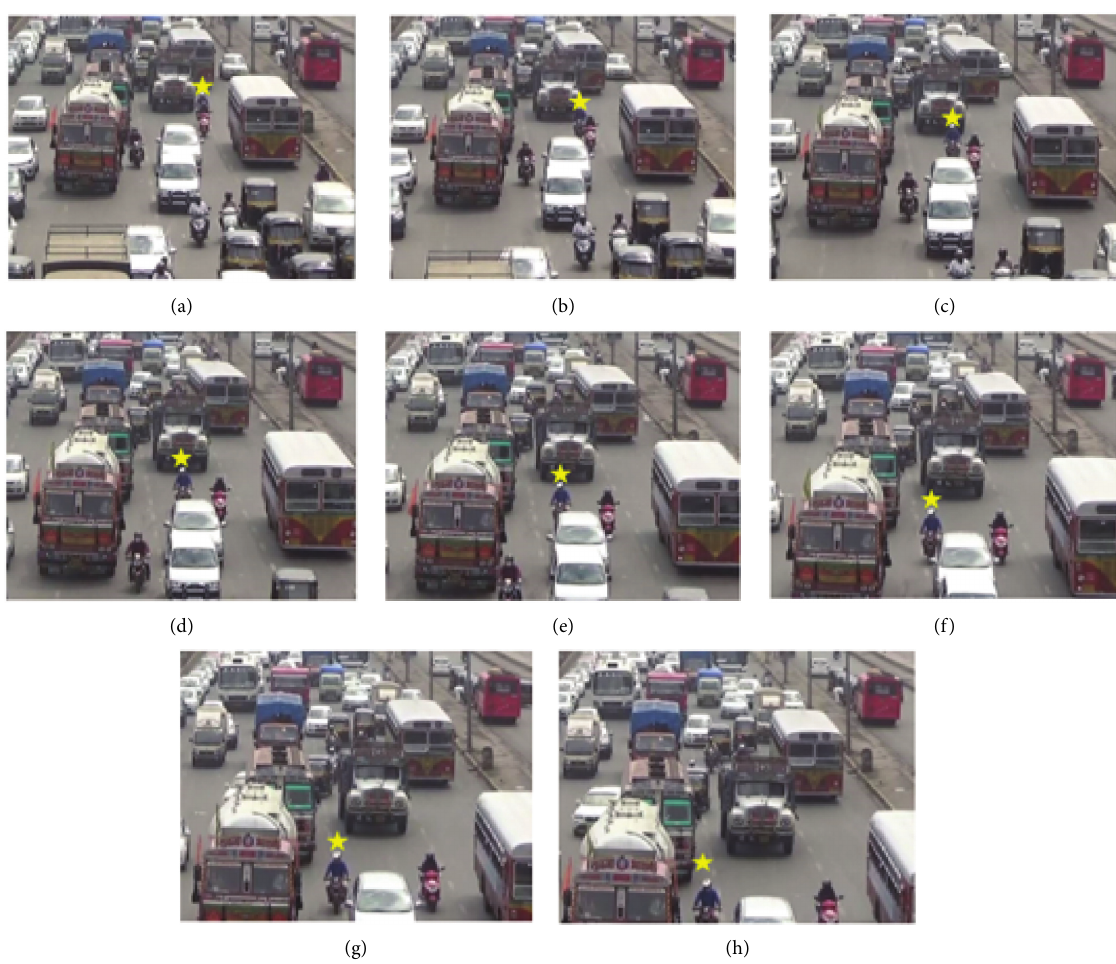
Figure 2: Movement of MTW over the road section at different time